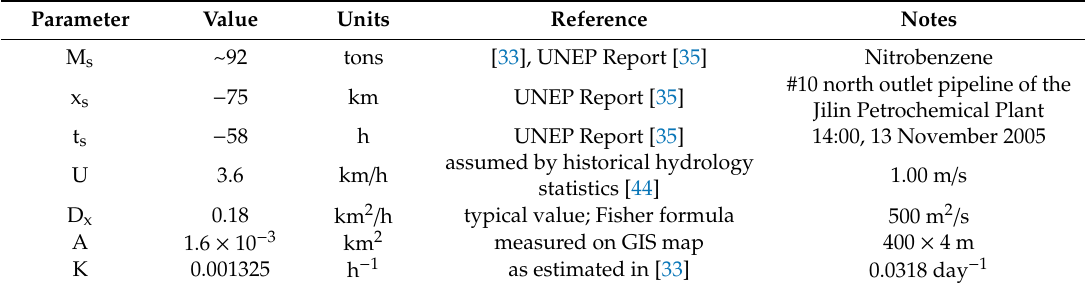
Table 1. Source and model parameter information for the case of the Songhua River spill.